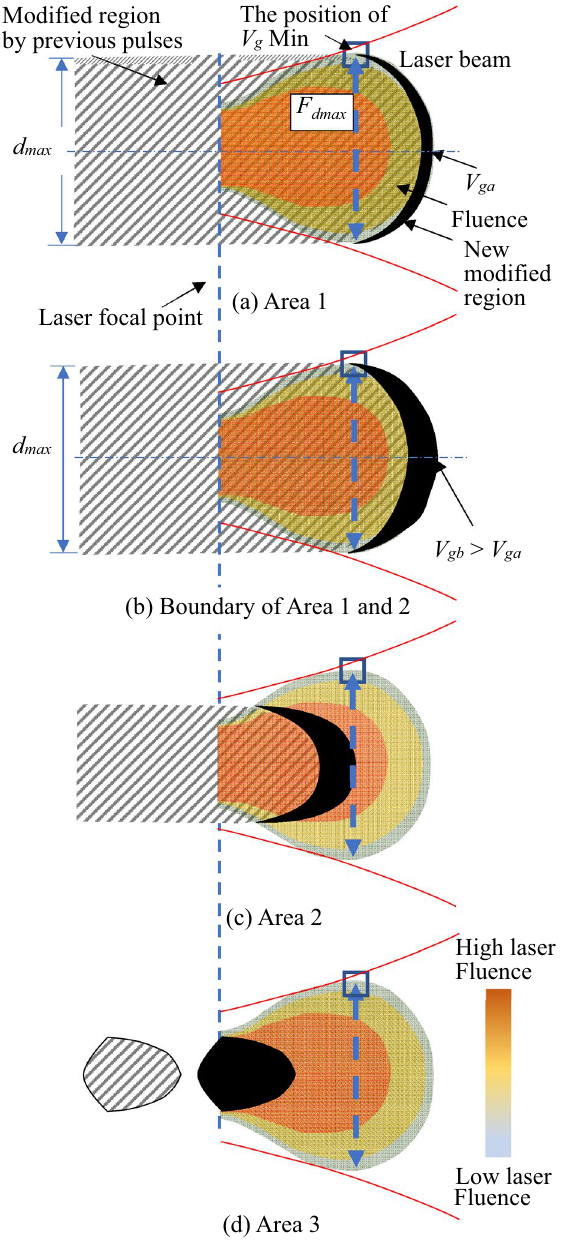
Figure 6. Schematic illustrations of fabrication process of a wire-shaped modified region fabricated at each area shown in Fig.